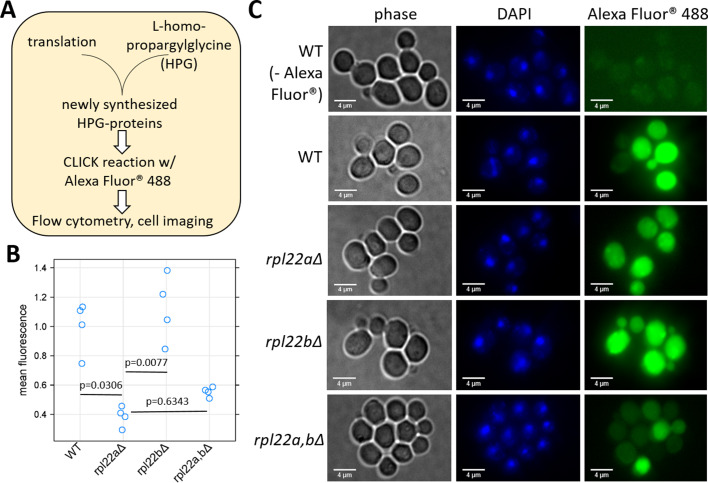
Reduced protein synthesis in cells lacking Rpl22Ap.(A) Schematic of the approach to measure incorporation of a methionine analog (HPG) in newly synthesized proteins (see Materials and methods). (B) The strains shown on the x-axis (all in the BY4742 background, the same as in Figure 1) were incubated with HPG for 30 m, processed for CLICK reaction with the Alexa dye, and then the fluorescence per cell was quantified with flow cytometry. At least 8,000–10,000 cells were quantified in each sample, from four independent experiments in each case. On the y-axis is the mean fluorescence per cell for each sample divided by the average of the four WT samples. Significant differences in pair-wise comparisons were indicated by the non-parametric Kruskal-Wallis test (p=0.004848), while the p-values shown were based on the posthoc Nemenyi test (performed with the PMCMR R language package). (C) Representative images of HPG-Alexa-labeled cells, which were also stained with DAPI to visualize the nuclei.